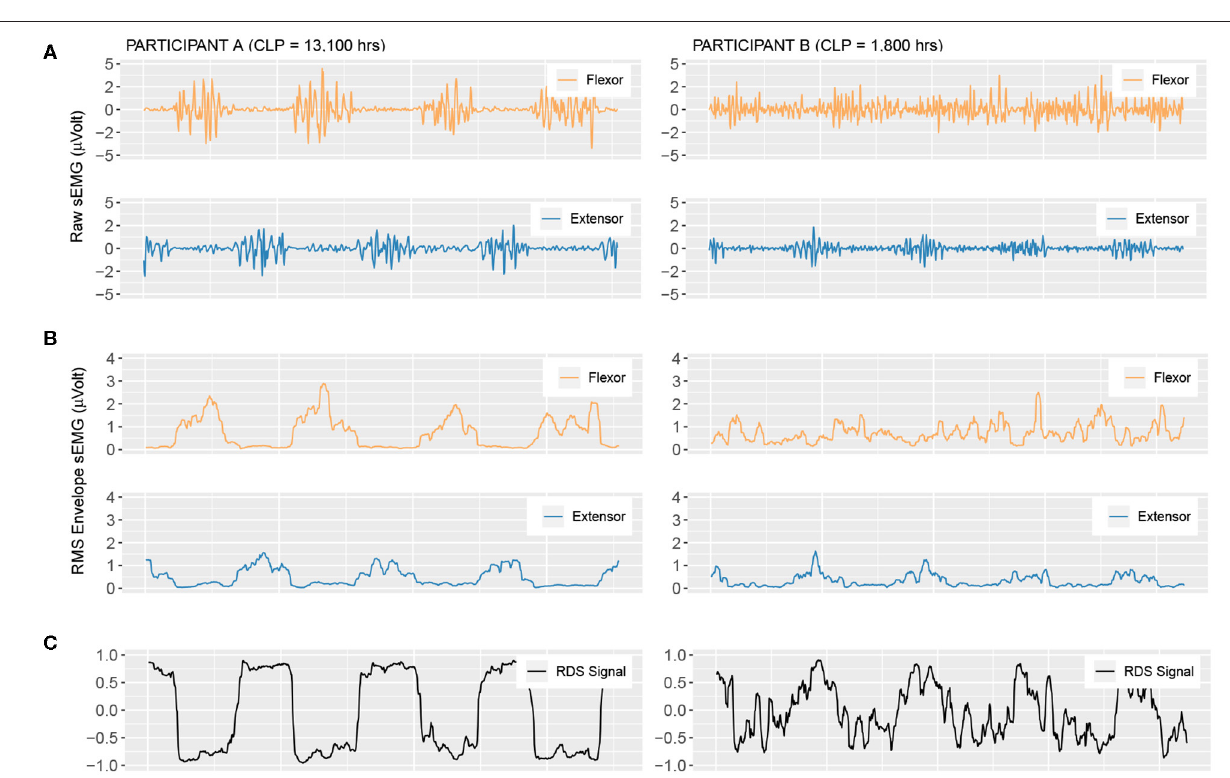
FIGURE 2 | Surface electromyography signals for the single right-hand solo exercise (RHSolo) at 400 HPM. Participant A (left-hand column) is a member of the Expert group (ED) with a Cumulative Lifetime Practice (CLP) of 13,100 h. Participant B (right-hand column) is a member of the Amateur group (AD), with a Cumulative Lifetime Practice (CLP) of 1,800 h. (A) The raw sEMG signals of both flexor and extensor (B) The corresponding RMS Envelope signals. (C) The resultant relative difference signal